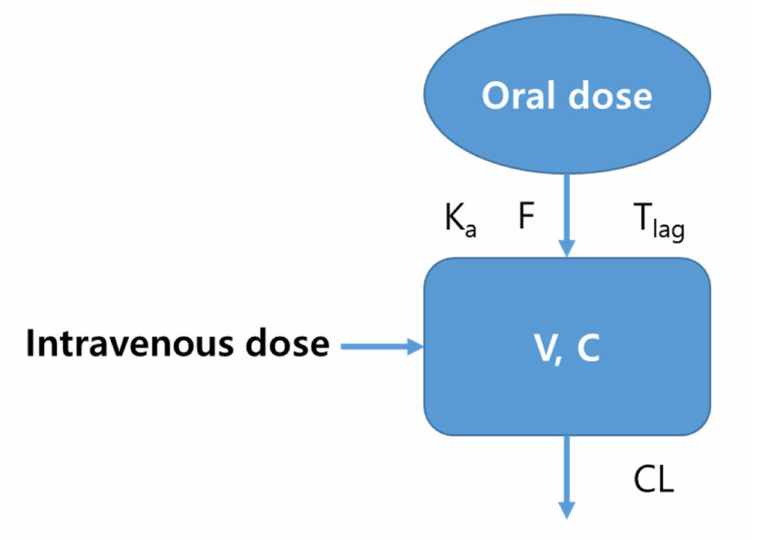
Figure 7. Structure of the population pharmacokinetic model of methotrexate-loaded nanoformula- tions (including nanoemulsions and